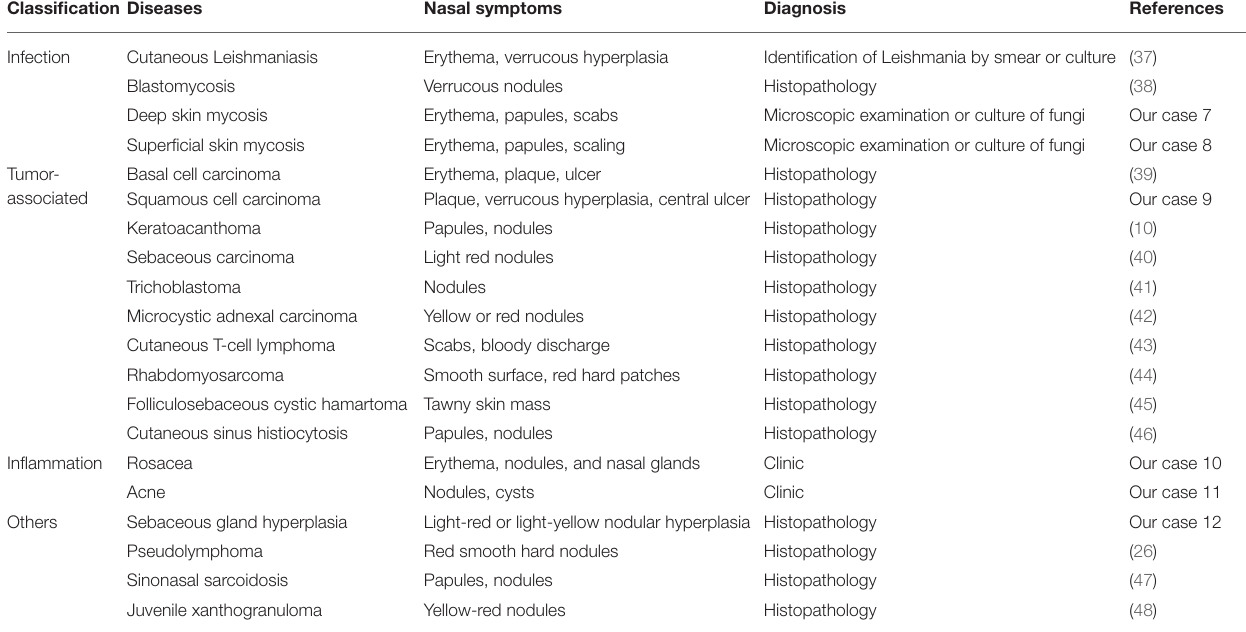
TABLE 4 | Primary diseases that can present with clown nose-like